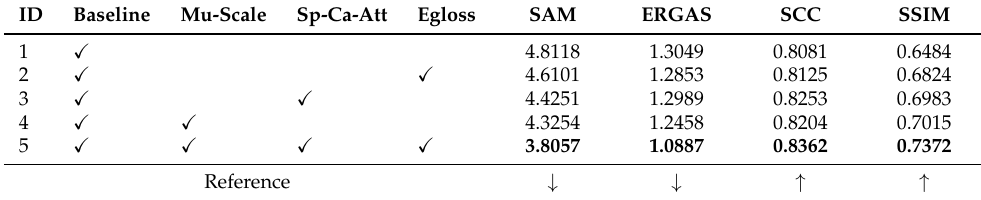
Table 1. Performance of different modules on the CIA dataset.